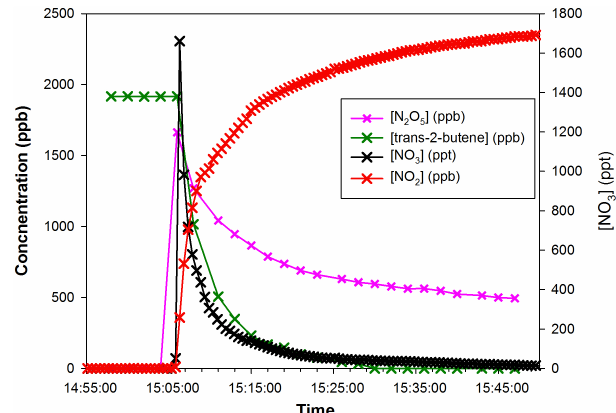
Figure 7. Concentrations of trans -2-butene and NO 2 measured by FTIR (left axis) and NO 3 measured by IBBCEAS vs. time (right axis) during Experiment